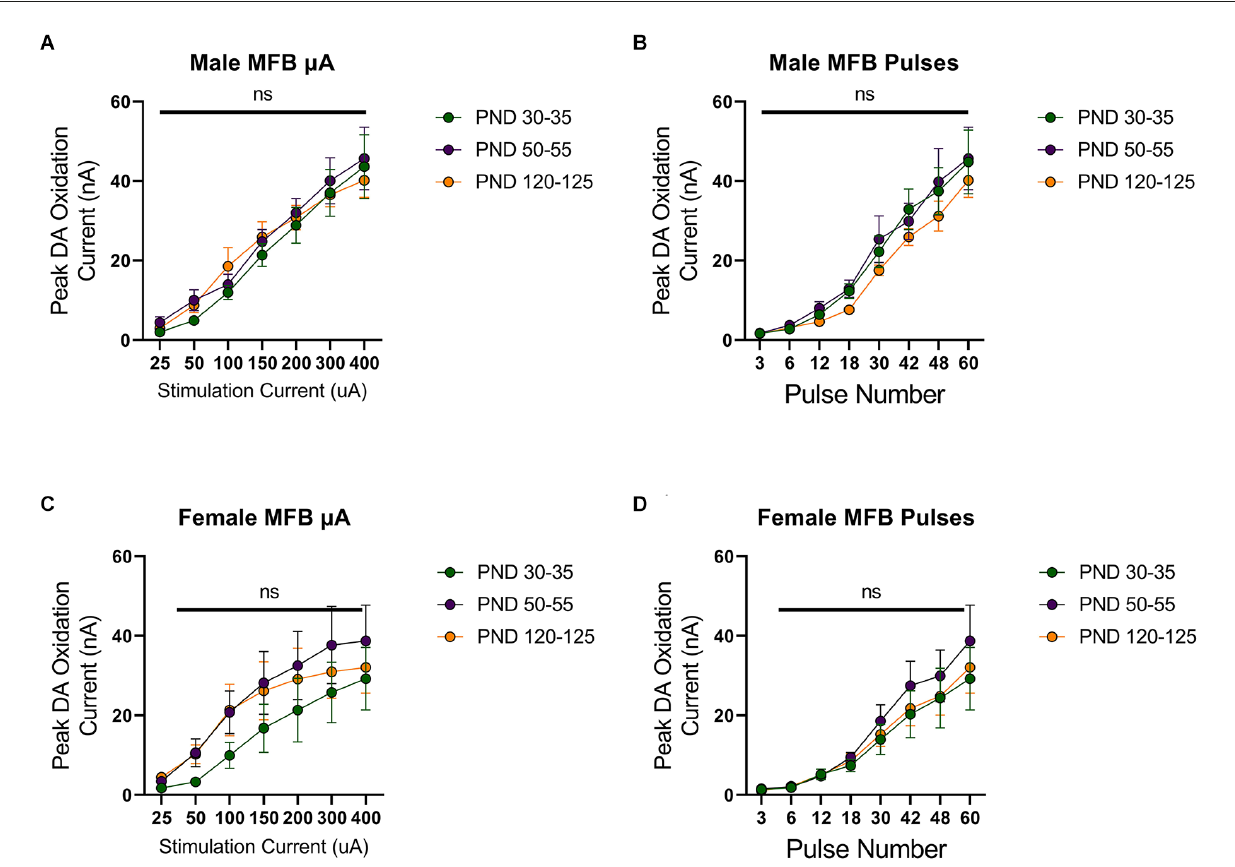
FIGURE1 Peak dopamine (DA) oxidation current (nA) recordings in the nucleus accumbens (NAcc) over time after a single electrical stimulation of the medial forebrain bundle (MFB) in Males (A,B) and Females (C,D) averaged over varying stimulation currents (A,C) and pulses (B,D) at various ages. (A) Males’ PND 50–55 ( n = 5) did not significantly differ from PND 30–35 ( n = 4) and PND 120–125 ( n = 4) in phasic DA release in the NAcc after stimulation of theMFBwithincreasingstimulationcurrent. (B) Males’PND50–55( n =4)didnotsignificantlydifferfromPND30–35( n =4)andPND120–125( n =4) in phasic DA release in the NAcc after stimulation of the MFB with increasing pulse number. (C) Females’ PND 50–55 ( n = 6) did not significantly differ from PND 30–35 ( n = 4) and PND 120–125 ( n = 4) in phasic DA release in the NAcc after stimulation of the MFB with increasing stimulation current. (D) Females’ PND 50–55 ( n = 6) did not significantly differ from PND 30–35 ( n = 4) and PND 120–125 ( n = 6) in phasic DA release in the NAcc after stimulation of the MFB with increasing pulse number. All data are presented as mean ± SEM for the peak DA oxidation current according to stimulation current (25, 50, 100, 150, 200, 300, and 400 nA) and pulse number (3, 6, 12, 18, 30, 42, 48, and 60). ns p > 0.05.